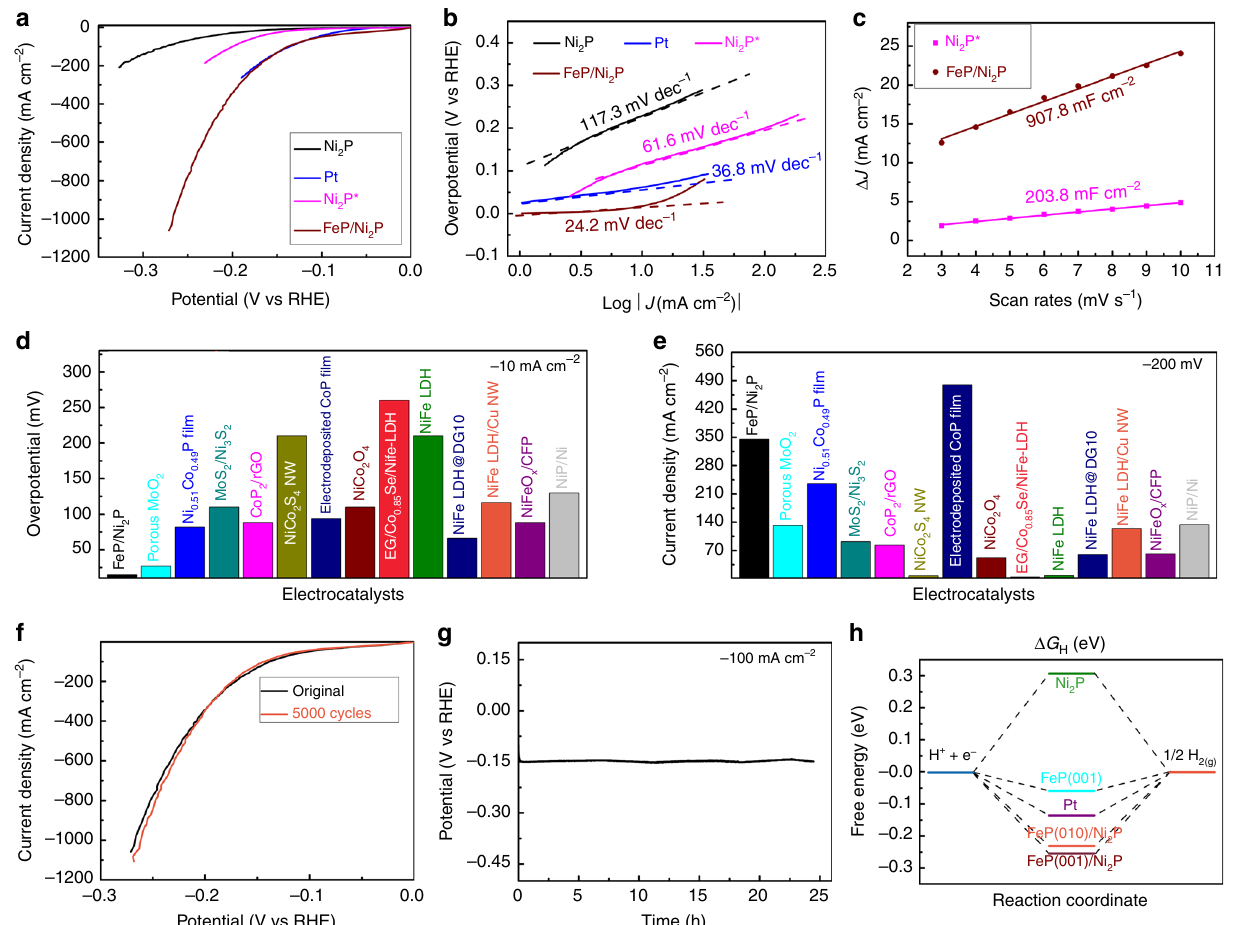
Fig. 3 Electrocatalytic hydrogen evolution reaction. a The HER polarization curves of different catalysts. b The relevant Tafel plots. c Double-layer capacitance measurements for determining electrochemically active surface areas of Ni 2 P and FeP/Ni 2 P electrodes. d Comparison of the overpotentials required at 10 mA cm − 2 among our catalyst and available reported HER catalysts. e Comparison of the current densities delivered at − 200 mV among our catalyst and available reported HER catalysts. f Polarization curves before and after 5000 cycling test. g The chronopotentiometric curve of the FeP/Ni 2 P electrode tested at a constant current density of − 100 mA cm − 2 for 24 h. h Free energy diagram for Δ G H , the hydrogen adsorption free energy at pH = 14 on FeP/Ni 2 P catalyst in comparison with Ni 2 P and benchmark Pt catalysts. Electrolyte: 1 M